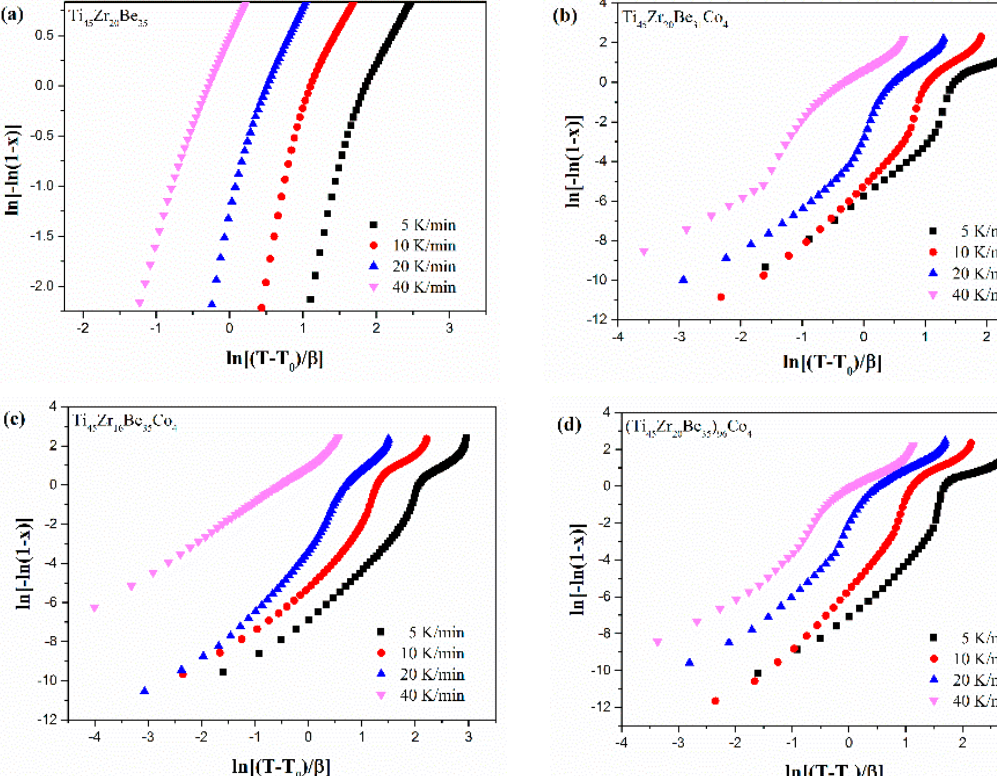
Figure 13. JMA plots for ( a ) Ti 45 Zr 20 Be 35 , ( b ) Ti 45 Zr 20 Be 31 Co 4 , ( c ) Ti 45 Zr 16 Be 35 Co 4 , and ( d )